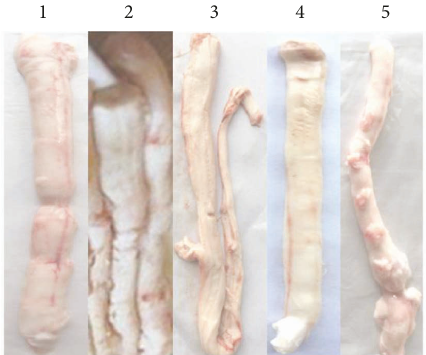
Figure 1: Morphological characteristics of bone marrow from four species. 1: Bone marrow from Bos taurus domesticus Gmelin; 2: bone marrow from Bubalus bubalis Linnaeus; 3: bone marrow from a species of pig; 4: bone marrow from a species of donkey; 5: bone marrow from a species of